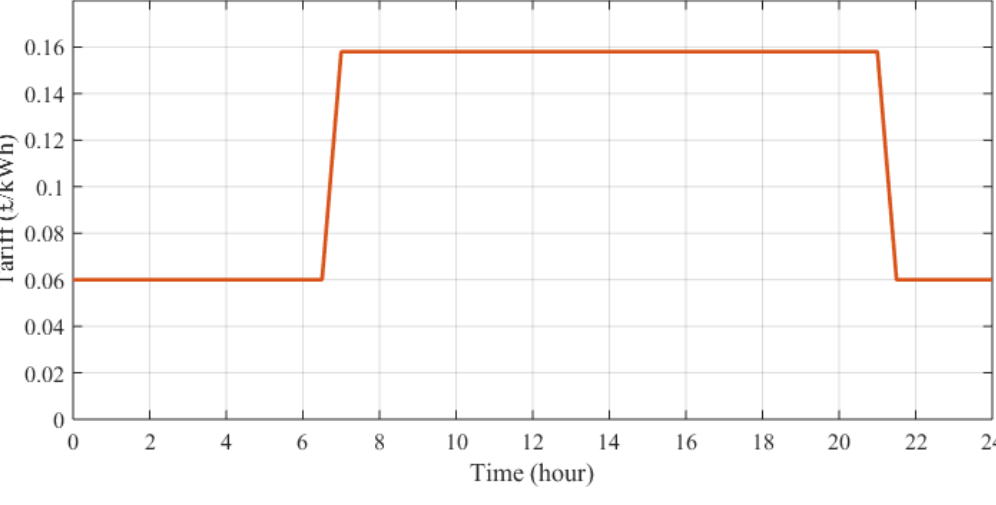
Figure 5. Economy 7 tariff.